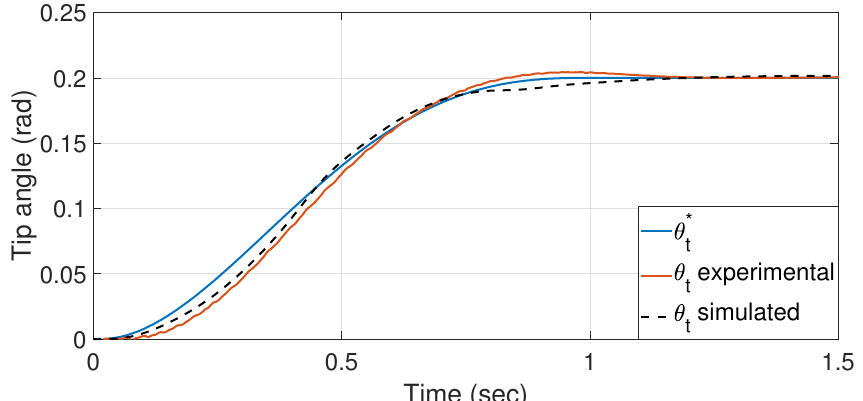
Figure 15. Comparison of the simulated and experimental tracking of a tip trajectory the FPD controller.